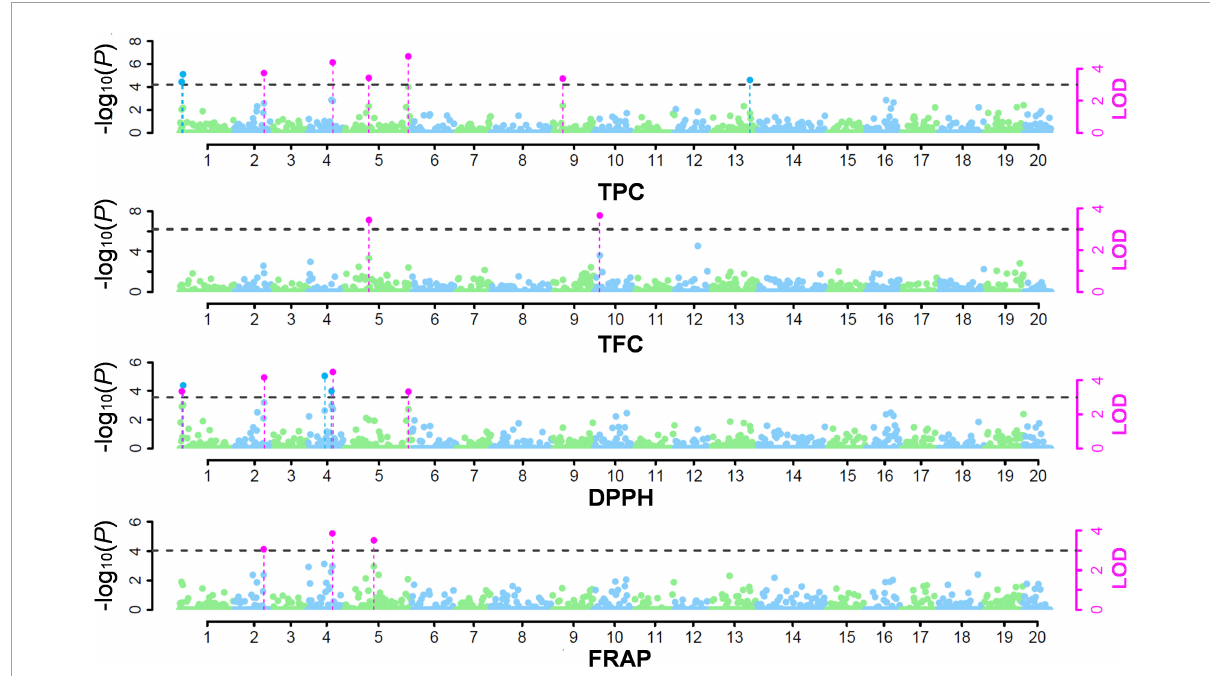
FIGURE2 GWAS results for the antioxidant-related traits. The dotted black lines indicate the significance threshold at LOD = 3.0. The significant QTNs detected by multiple and single GWAS methods are presented with pink and blue dots with vertical dotted lines, respectively. For the results by multiple methods, the median value of -log 10 ( P ) from the mrMLM, FASTmrMLM, FASTmrEMMA, and pKWmEB methods was used in